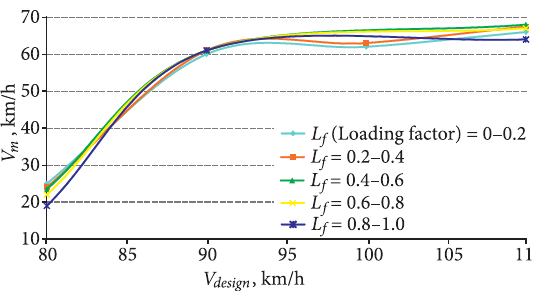
Fig. 6. Relation of 95% average momentary speed and design